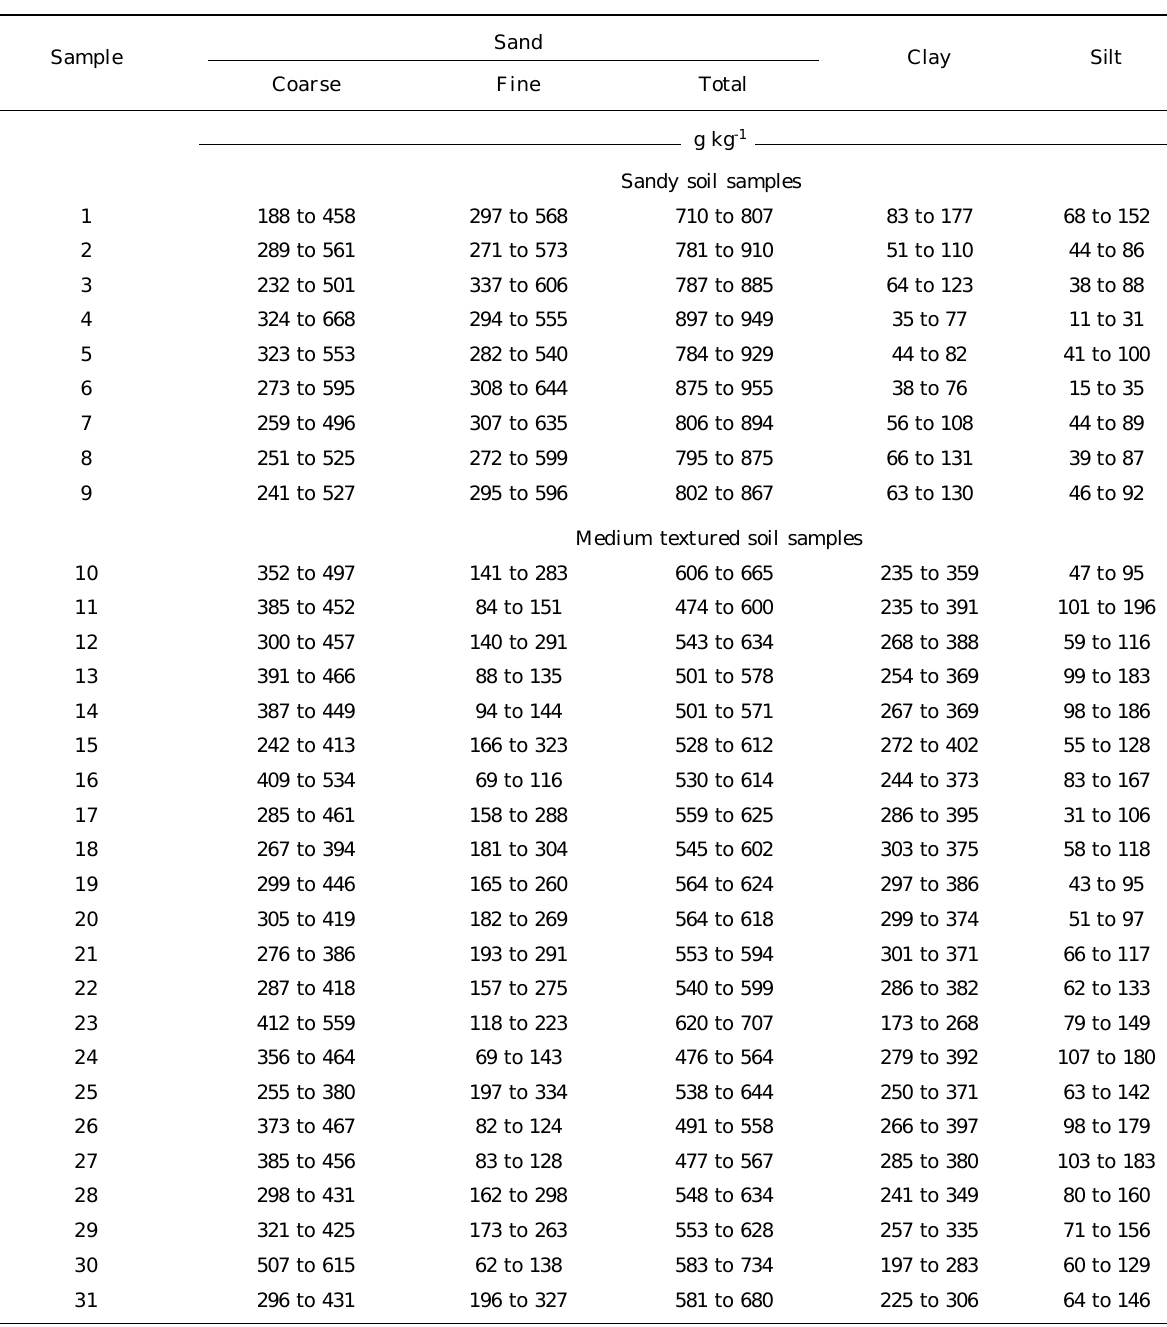
Table 1. Confidence intervals for coarse, fine and total sand, and silt and Clay contents for nine sandy and 22 medium textured soil